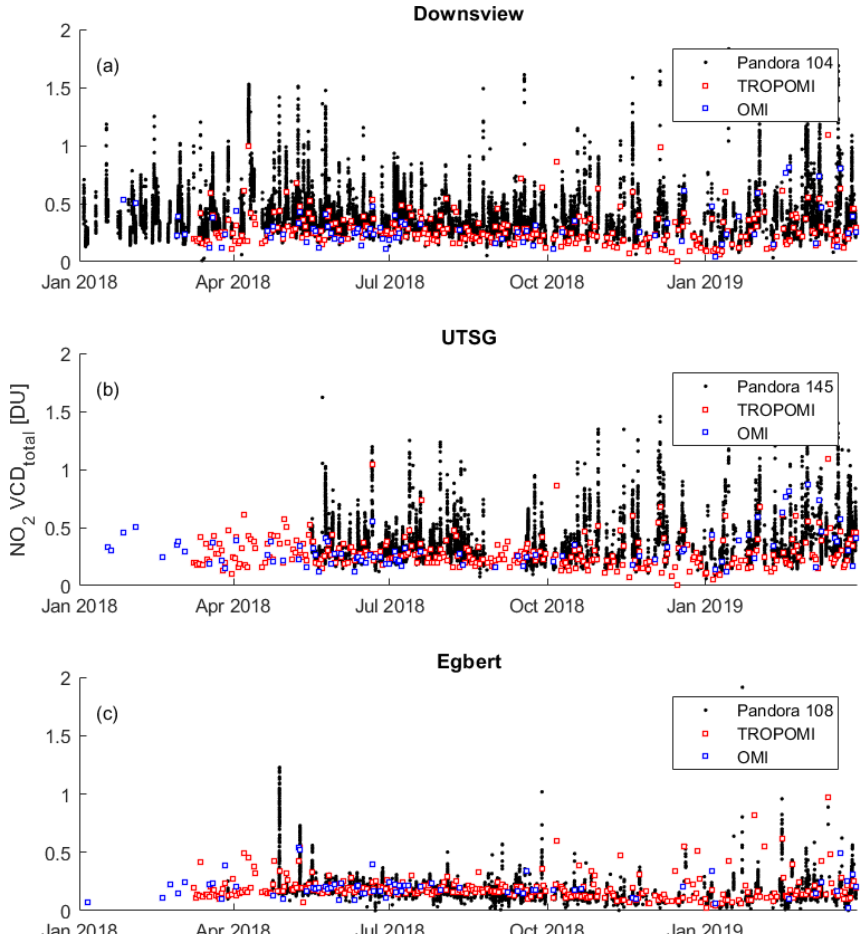
Figure 3. Time series of Pandora, TROPOMI, and OMI total column NO 2 in the Greater Toronto Area.